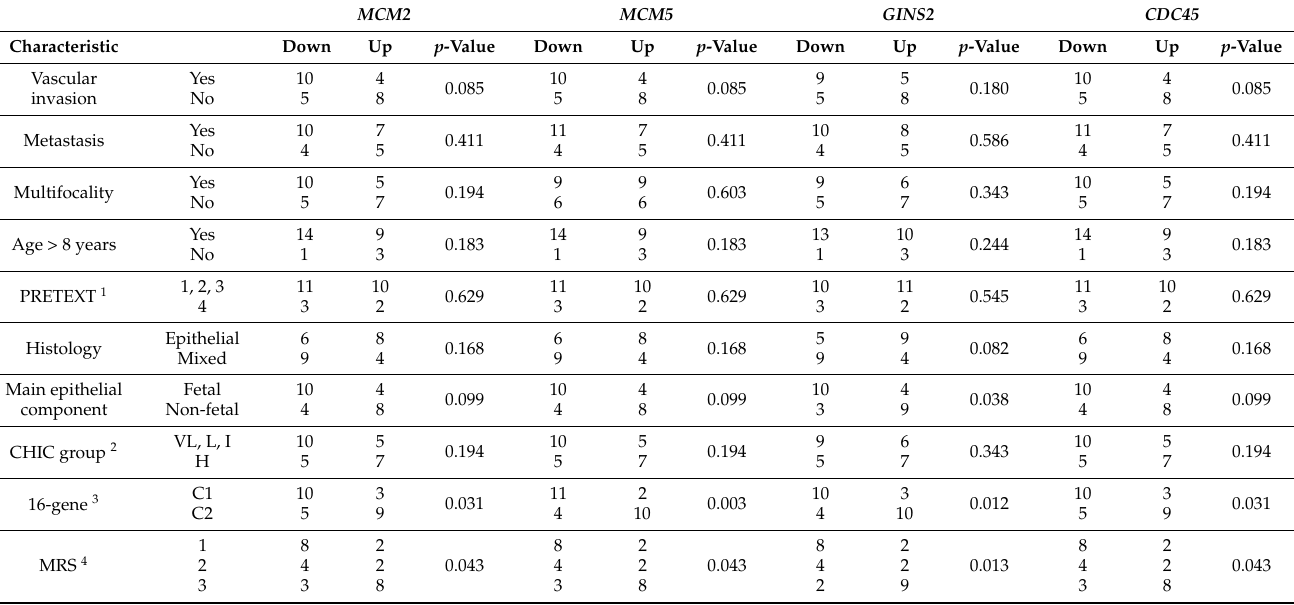
Table 1. Correlation of unwindosome gene expression with clinical and molecular